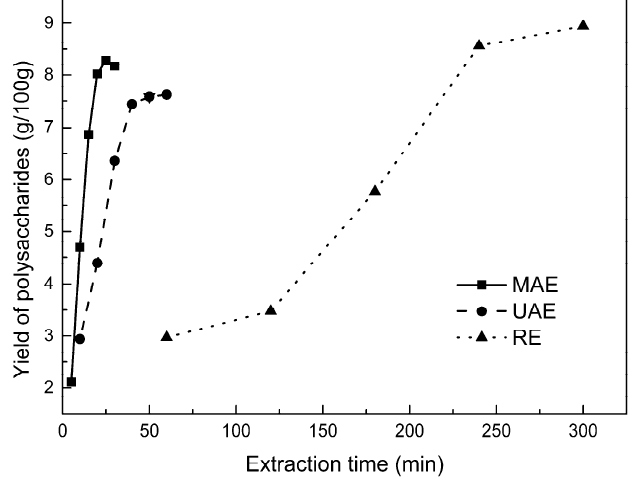
Figure 2. Kinetic study of polysaccharide